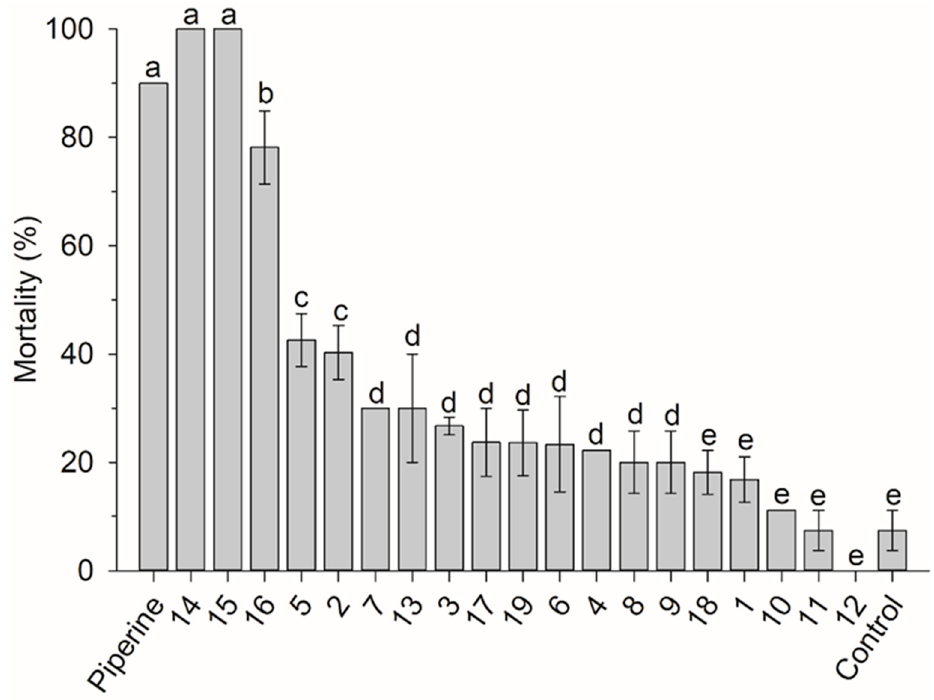
Figure 1. Mortality (%) of Tuta absoluta larvae 48 h after topical application of 19 amides and piperine at the dose of 30 μ g/mg of body weight. Different letters above bars indicate significant differences in mean mortalities according to ANOVA and Scott–Knott test ( P < 0.05). Control = acetone.